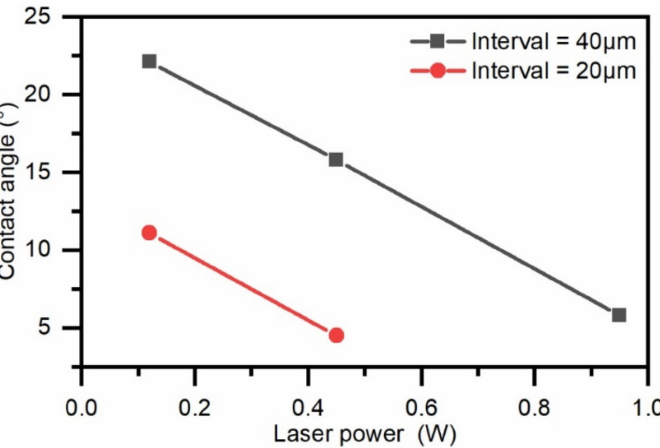
Figure 5. Contact angle of silicon irradiated by a femtosecond laser at different laser powers. The contact angle decreased with the decreasing scanning interval, as shown in Figure 6. The scanning interval of 40 µ m was wider compared with that of 10 µ m, so the laser irradiation area was much smaller than the interspace area. Therefore, water droplets dripping on the structure mainly contacted the silicon substrate, which made the contact angle large and close to that of the silicon without a pattern. When the scanning interval decreased, the laser irradiation area increased, so the surface hydrophilicity increased. The contact angle was less than 5 ◦ while the scanning interval was less than 10 µ m.